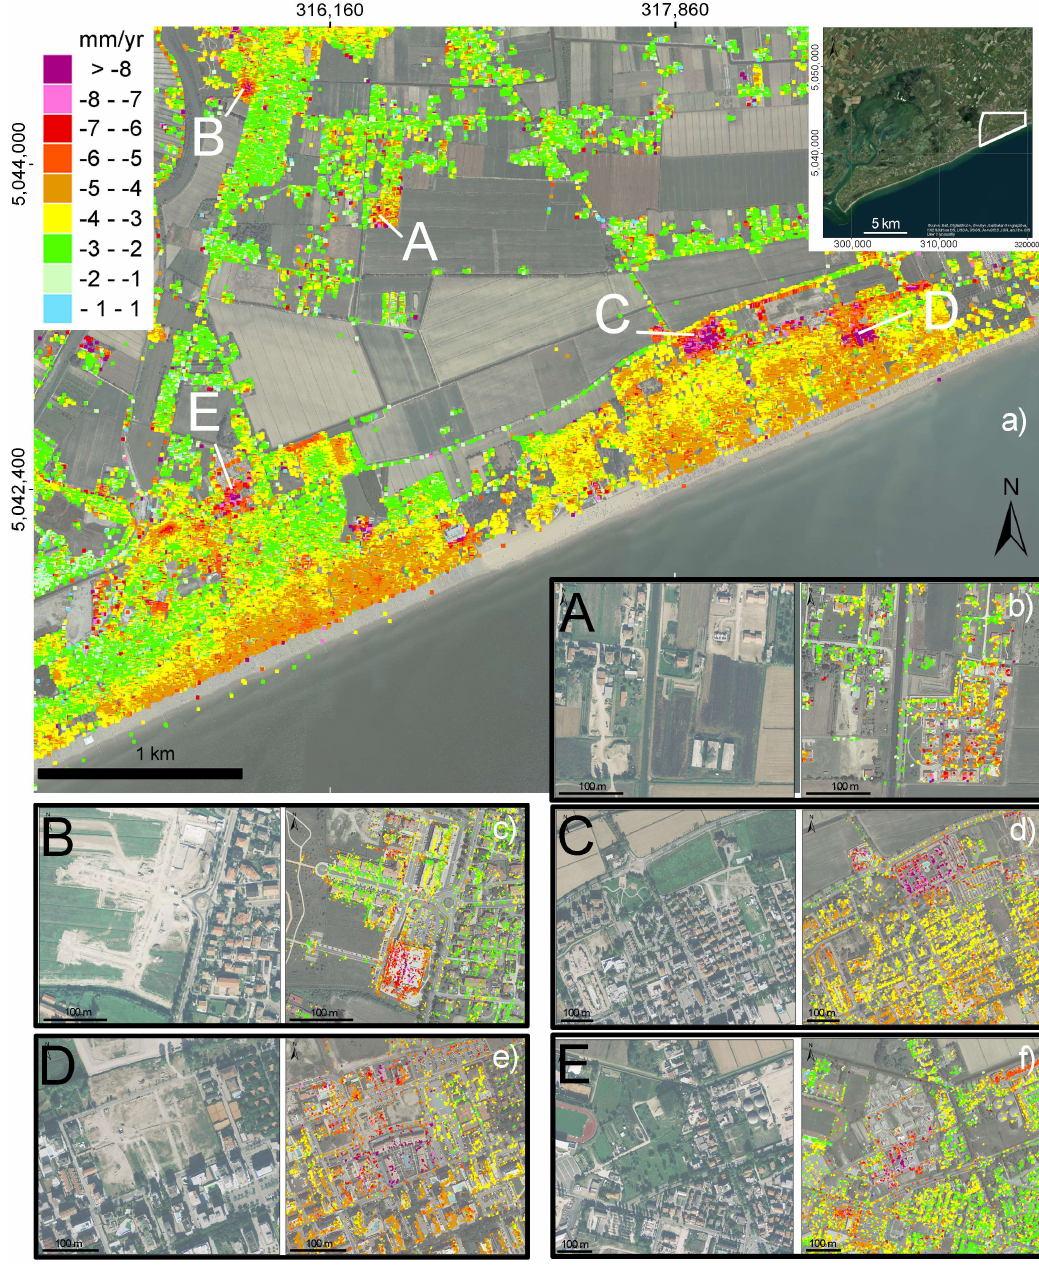
Figure 9. ( a ) Mean displacement rates from TerraSAR-X interferometry between March 2008 and November 2013 at the Jesolo coastland. A–E labels indicate local displacements induced by new urbanizations. ( b – f ) Blow ups of Areas A–E. Left and right background images are aerial photographs taken in 2006 and 2012, respectively. Base map source: http://www.pcn.minambiente.it/mattm/en/